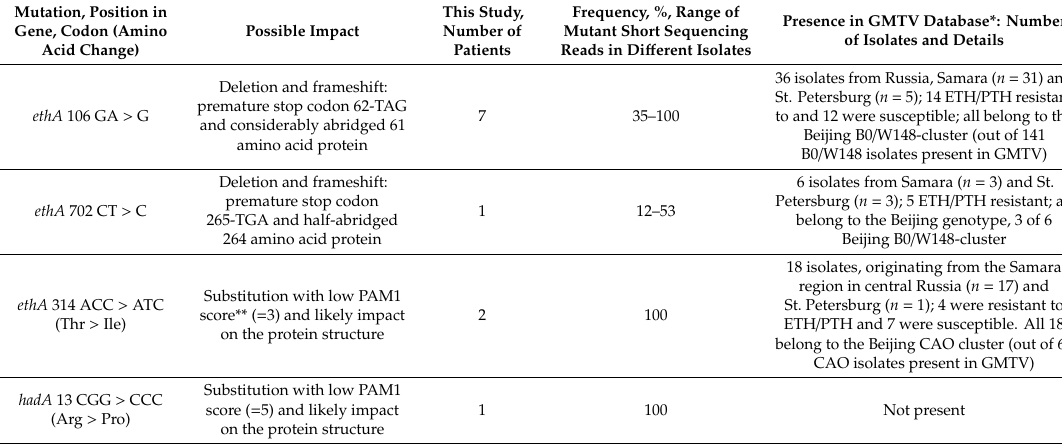
Table 3. Mutations in genes putatively associated with PCZ resistance in M. tuberculosis isolates recovered from PCZ-treated